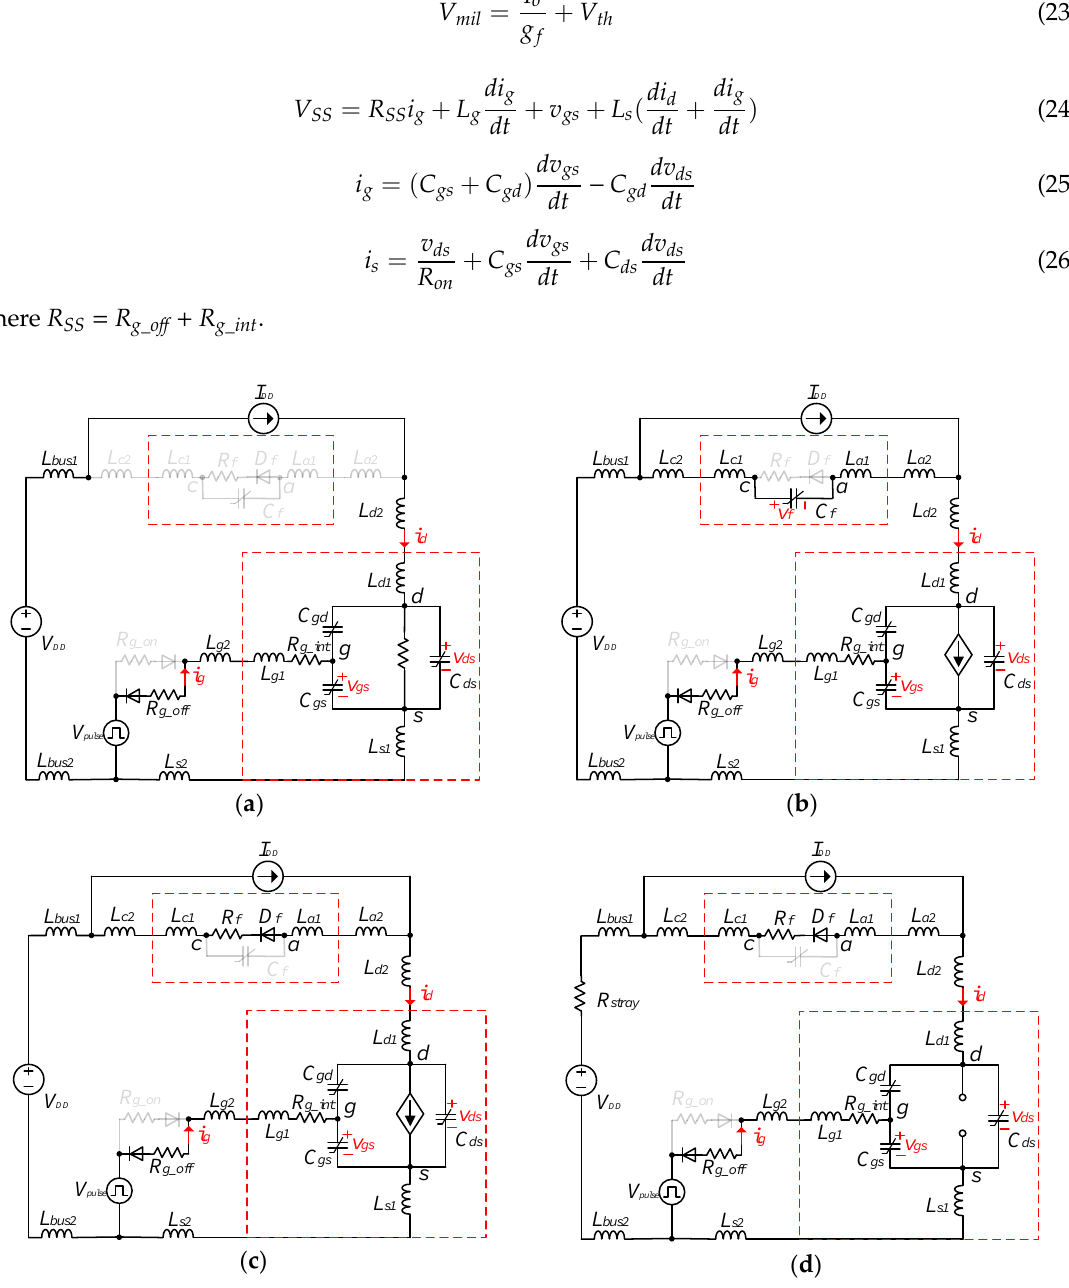
Figure 5. Equivalent circuits for the turn-off transients. ( a ) Stage 6 and Stage 7. ( b ) Stage 8. ( c ) Stage 9. ( d ) Stage10.